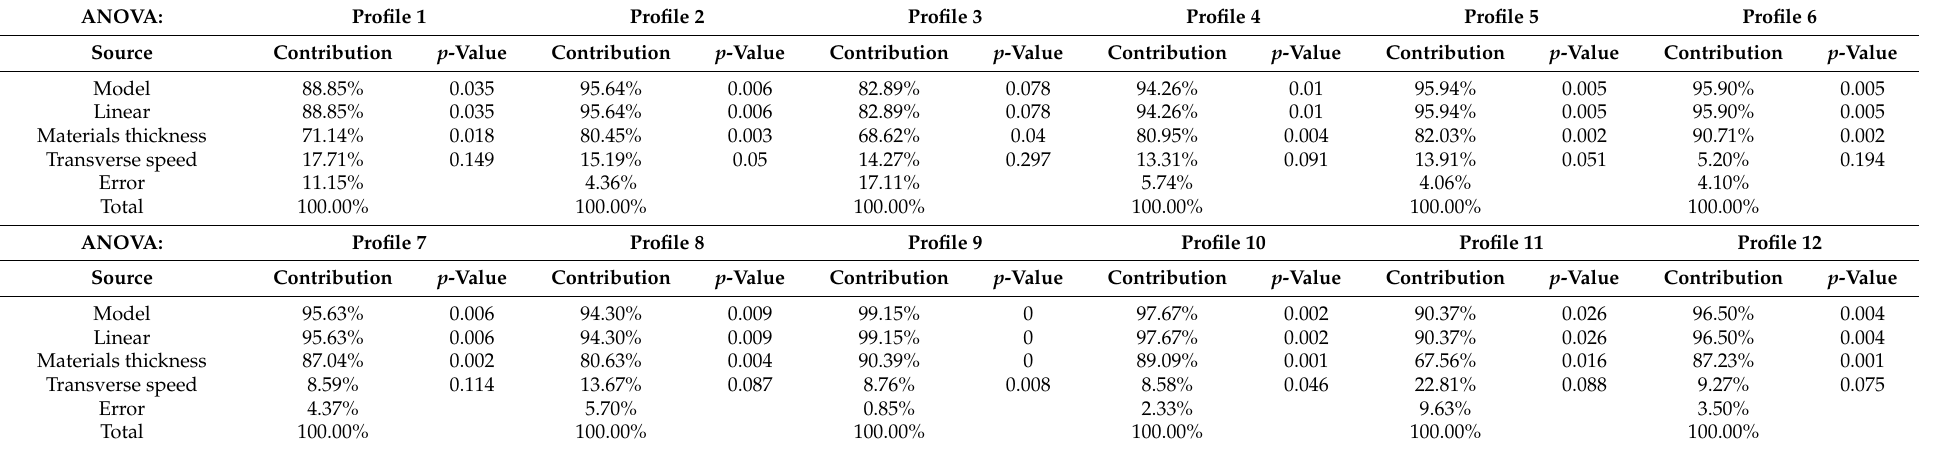
Table A2. Analysis of variance of Kerf taper angle.